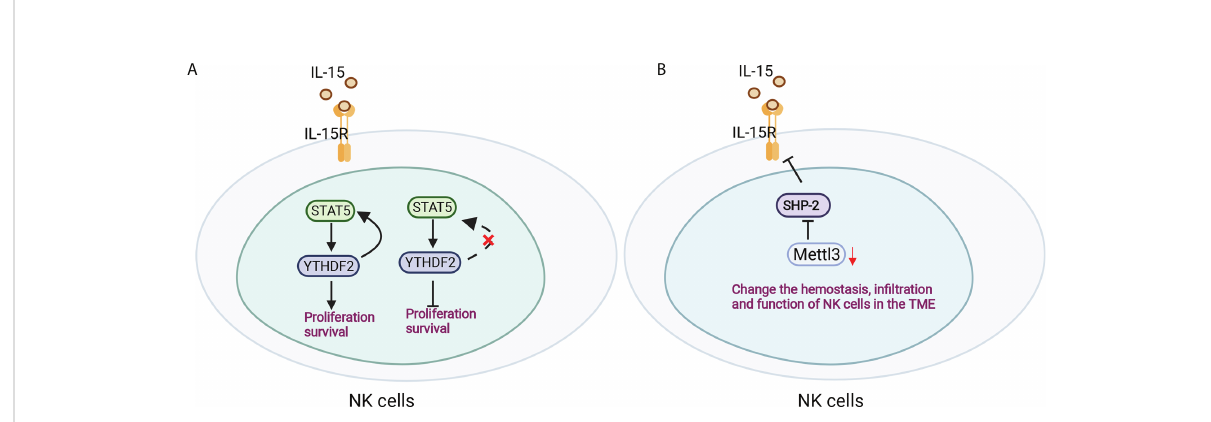
FIGURE 5 Antitumour immunity of NK cells was regulated by m6A modi fi cation. (A) YTHDF2 is essential for IL-15-mediated NK-cell survival and proliferation by the STAT5-YTHDF2 positive feedback loop. (B) Mettle3 ablation in NK cells changed the hemostasis, in fi ltration and function of NK cells by modifying SHP-2 mRNA in the tumor